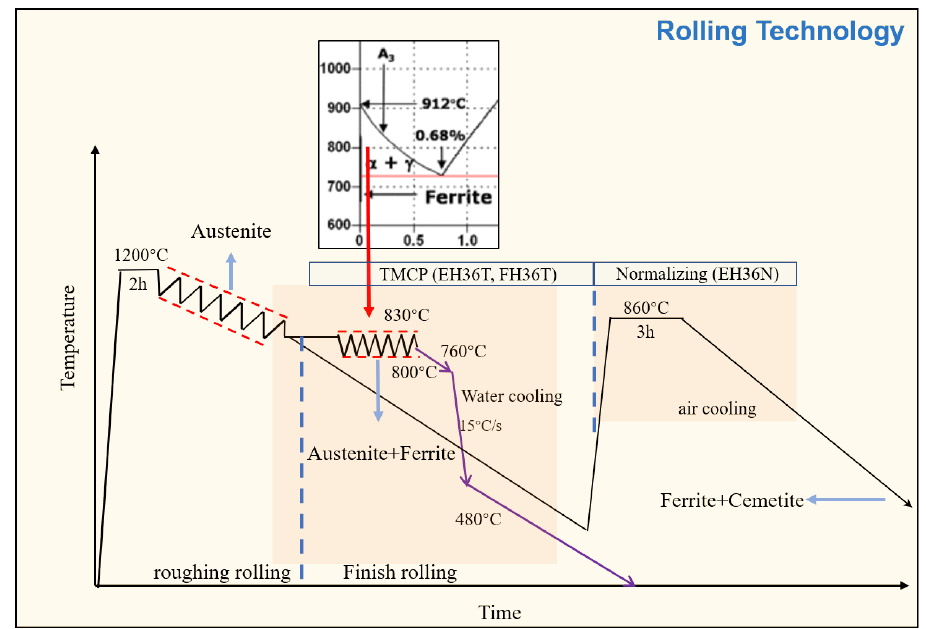
Figure 1. Manufacture process of offshore steels. Table 1. Chemical composition of the experimental steels (wt.%).